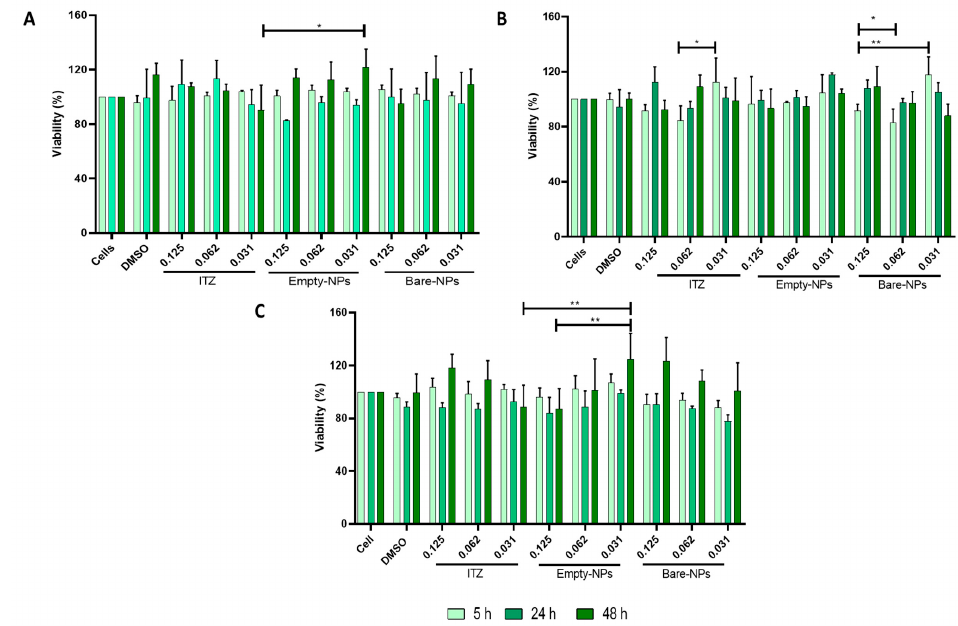
Figure 2. Cytotoxicity evaluation of ITZ encapsulated into PLGA75:25 TPGS-pH5 NPs by MTT with ( A ) J774A.1 (peritoneal mice macrophages), ( B ) AMJ2-C11 (alveolar mice macrophages), ( C ) THP-1 (human macrophages), with different concentrations and 0.125, 0.062, and 0.031 µg/mL ITZ for 5, 24, and 48 h, treatment with free ITZ and empty NPs and DMSO as controls. *, and ** indicate statistically significant differences with p < 0.01, and p < 0.001, respectively.